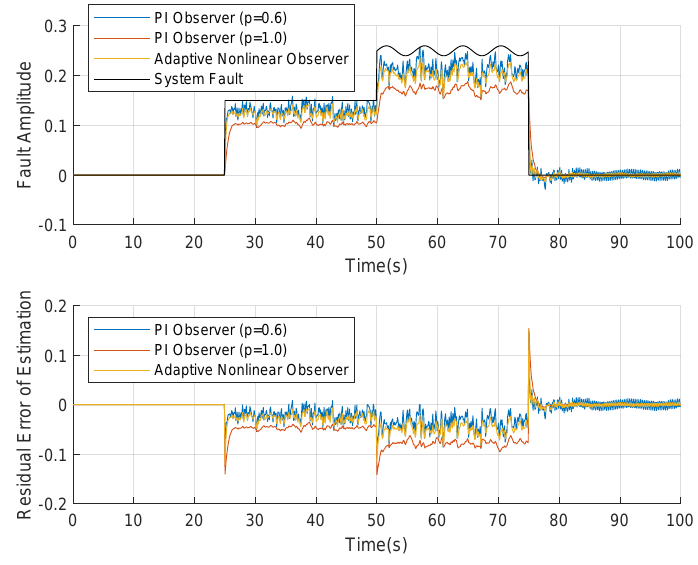
Figure 6. Fault estimation of nonlinear observer with adaptive parameters (with